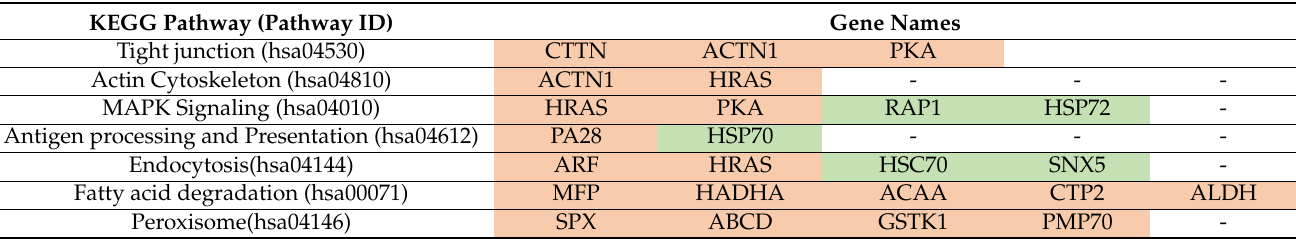
Table 1. KEGG pathways related to the DEPs of sample L and the associated genes. Green: down- regulated, red: up-regulated. KEGG: Kyoto Encyclopedia of Genes and Genomes.